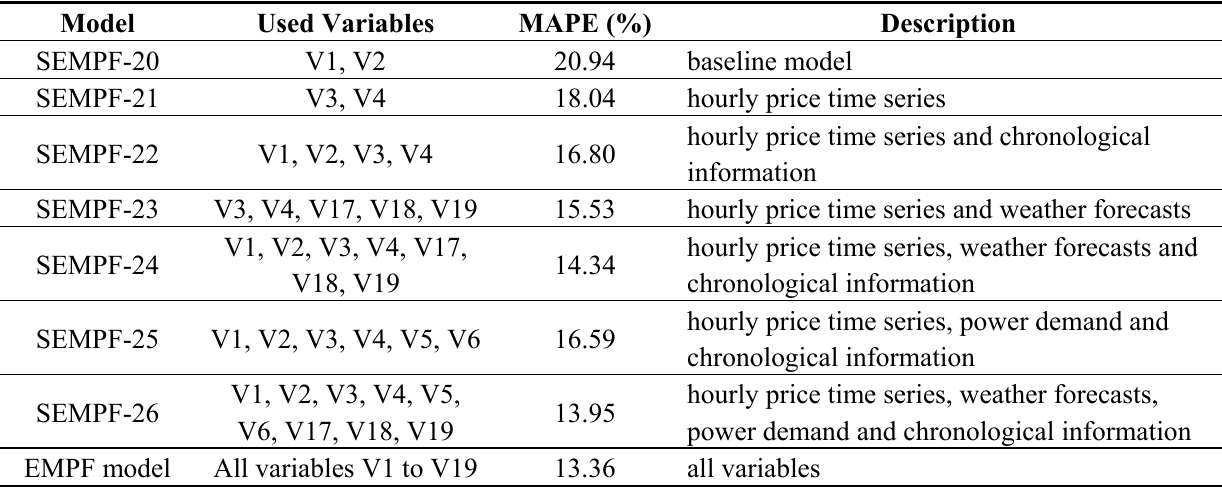
Table 5. EMPF and simpler explanatory models for price forecast (SEMPF) models input variables and their MAPE